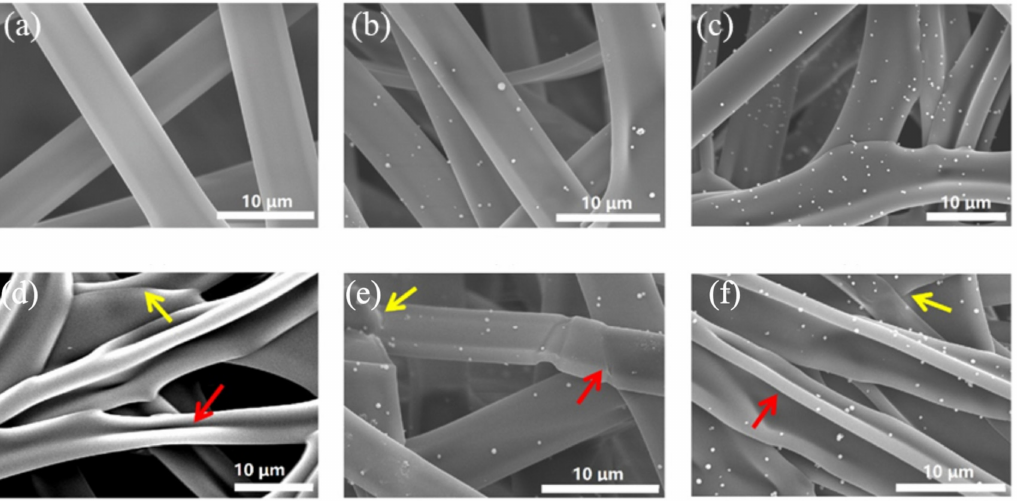
Figure 3. SEM images of ( a ) GZ0 (cid:48) , ( b ) GZ1 (cid:48) , ( c ) GZ2 (cid:48) , ( d ) GZ0, ( e ) GZ1, and ( f ) GZ2. GZ0 (cid:48) , GZ1 (cid:48) , and GZ2 (cid:48) represent gelatin/ZnO fibers with a concentration of 0%, 0.1%, and 0.25% in the ZnO particle solution during the electrospinning process, respectively. GZ0, GZ1, and GZ2 represent GZ0 (cid:48) , GZ1 (cid:48) , and GZ2 (cid:48) after cross-linking. Referred from